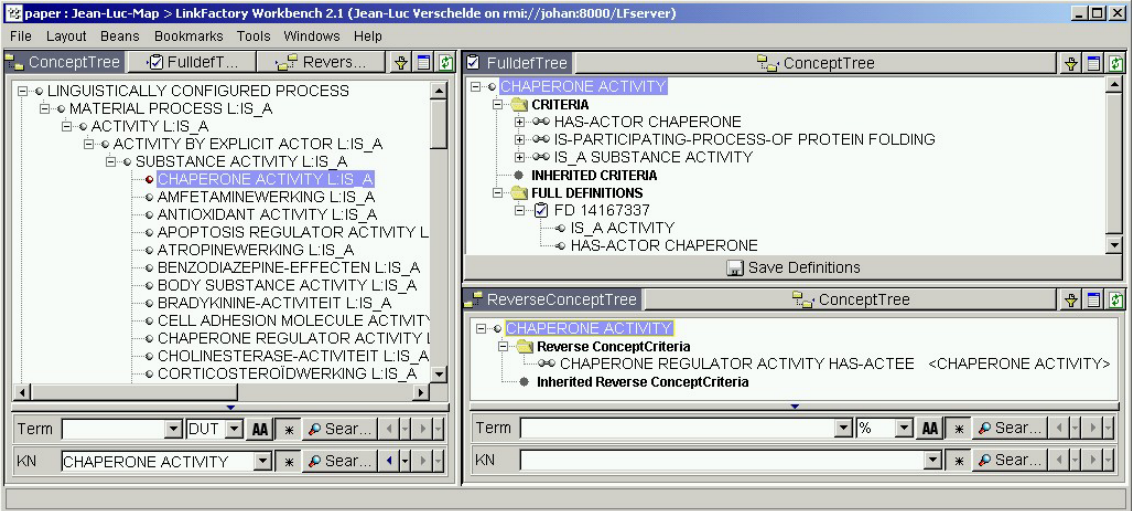
Figure 1: This frame shows a view of the semantic representation of <chaperone activity> 3 , using the ConceptTree bean linked to a FullDef and